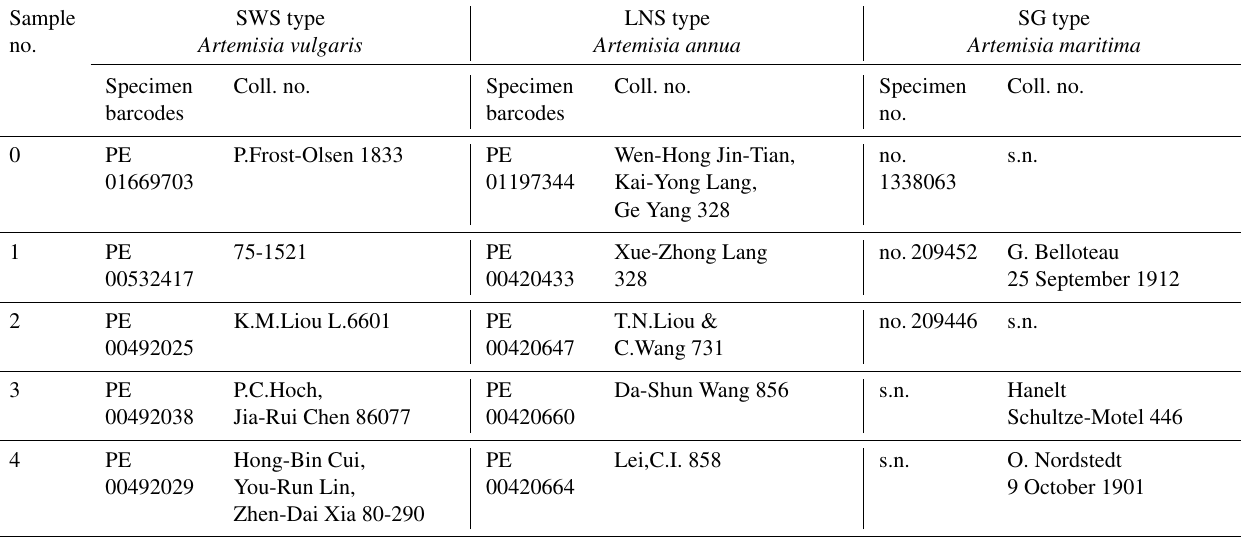
Table B2. List of the voucher specimens in PE Herbarium, Institute of Botany, Chinese Academy of Sciences. Sample no. 0 was the specimen for cluster analysis. Sample nos. 1–4 were used in testing intraspecific variability in pollen exine ultrastructure characters among three representative